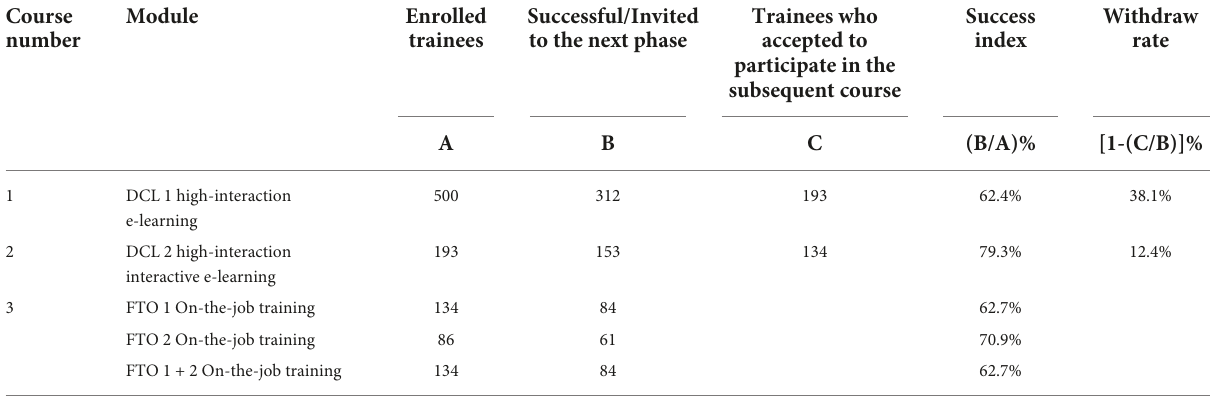
TABLE 3 Participation pattern described by enrolled, successful, trainees who accepted at different phases. Course